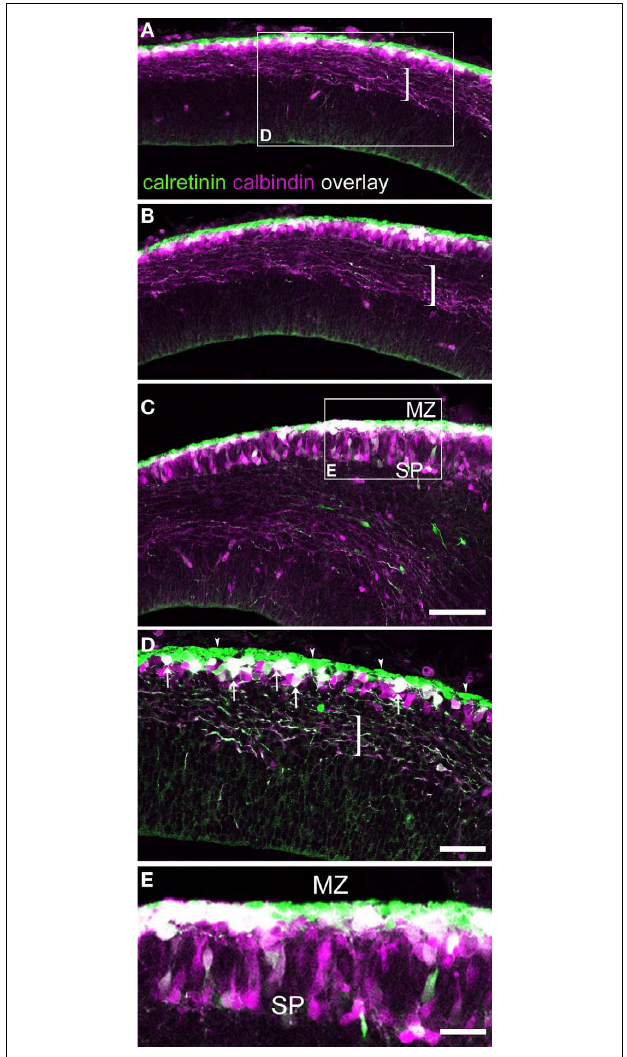
FIGURE 1 | Calcium binding protein expression in the preplate and its derivatives. E15.5 rat. (A–C) are views of single confocal sections of the preplate taken from medial to lateral, displaying a well known latero-medial developmental gradient. (C) shows the partition of the preplate. Brackets indicate pioneer axons emitted by pioneer neurons in the preplate. The majority of these axons co-expressed CB and CR. (D) From the boxed area in (A): arrowheads indicate a layer of densely packed CR + cells, interpreted as Cajal-Retzius cells. Co-expression of CB and CR appeared in white. Arrows point to double labeled, CB + /CR + cells. Cells expressing CB only interspersed among CB + /CR + cells. (E) From the boxed area in (C): when the preplate became partitioned into marginal zone and subplate, co-expression of CB and CR was more common in the marginal zone than in the subplate. MZ, marginal zone; SP, subplate. Calibration bars: (A–C) 100 µm; (D) 50 µm; (E) 30